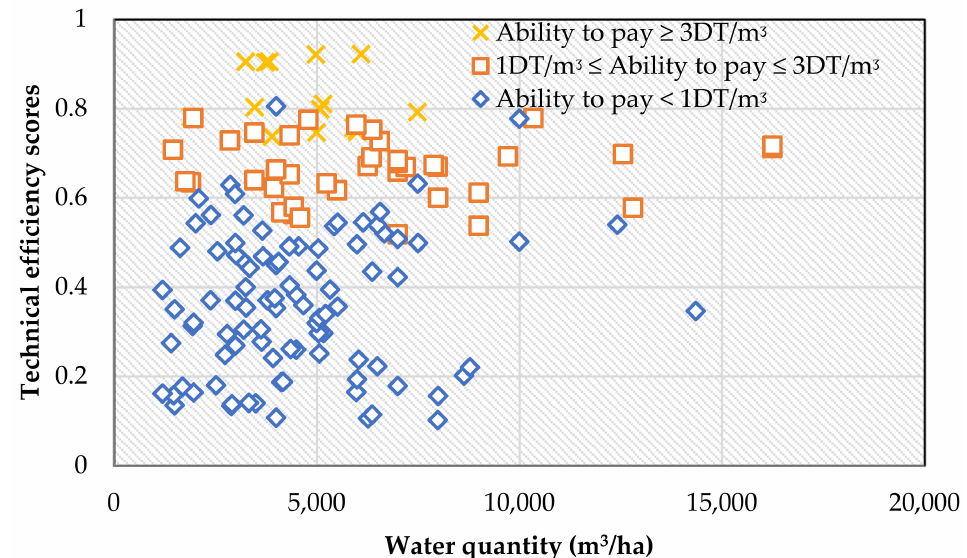
Figure 3. Technical efficiency scores per quantity of water consumed and ability to pay. Source: Own elaboration based on model results